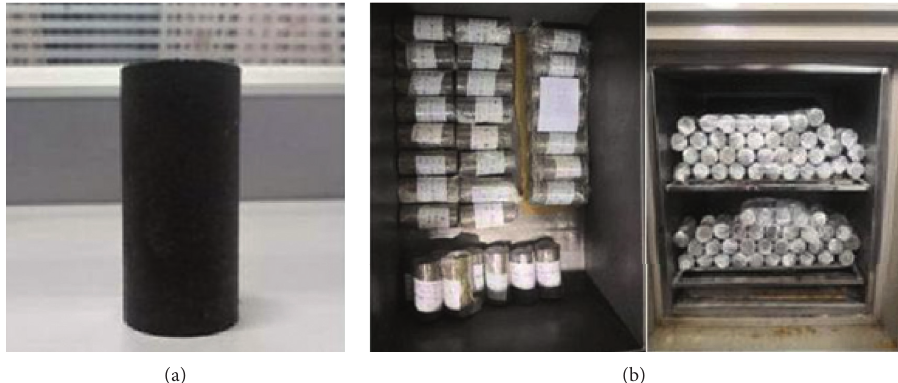
Figure 1: Rock samples: (a) standard rock sample and (b) sample preparation. Table 1: Rock physical properties.